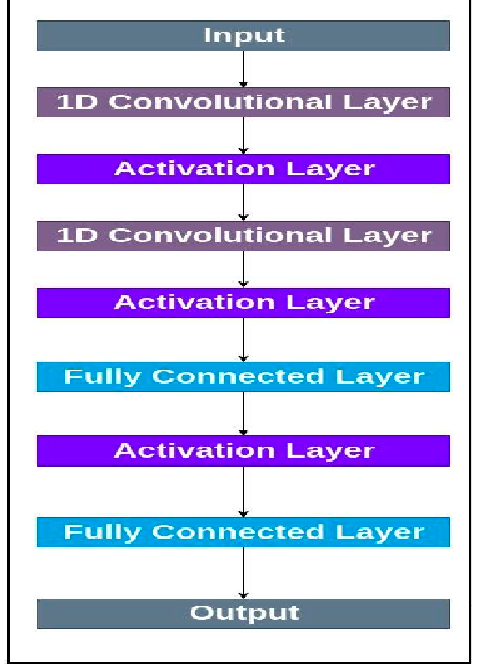
Figure 10. The architecture of the proposed CNN-based classifier.